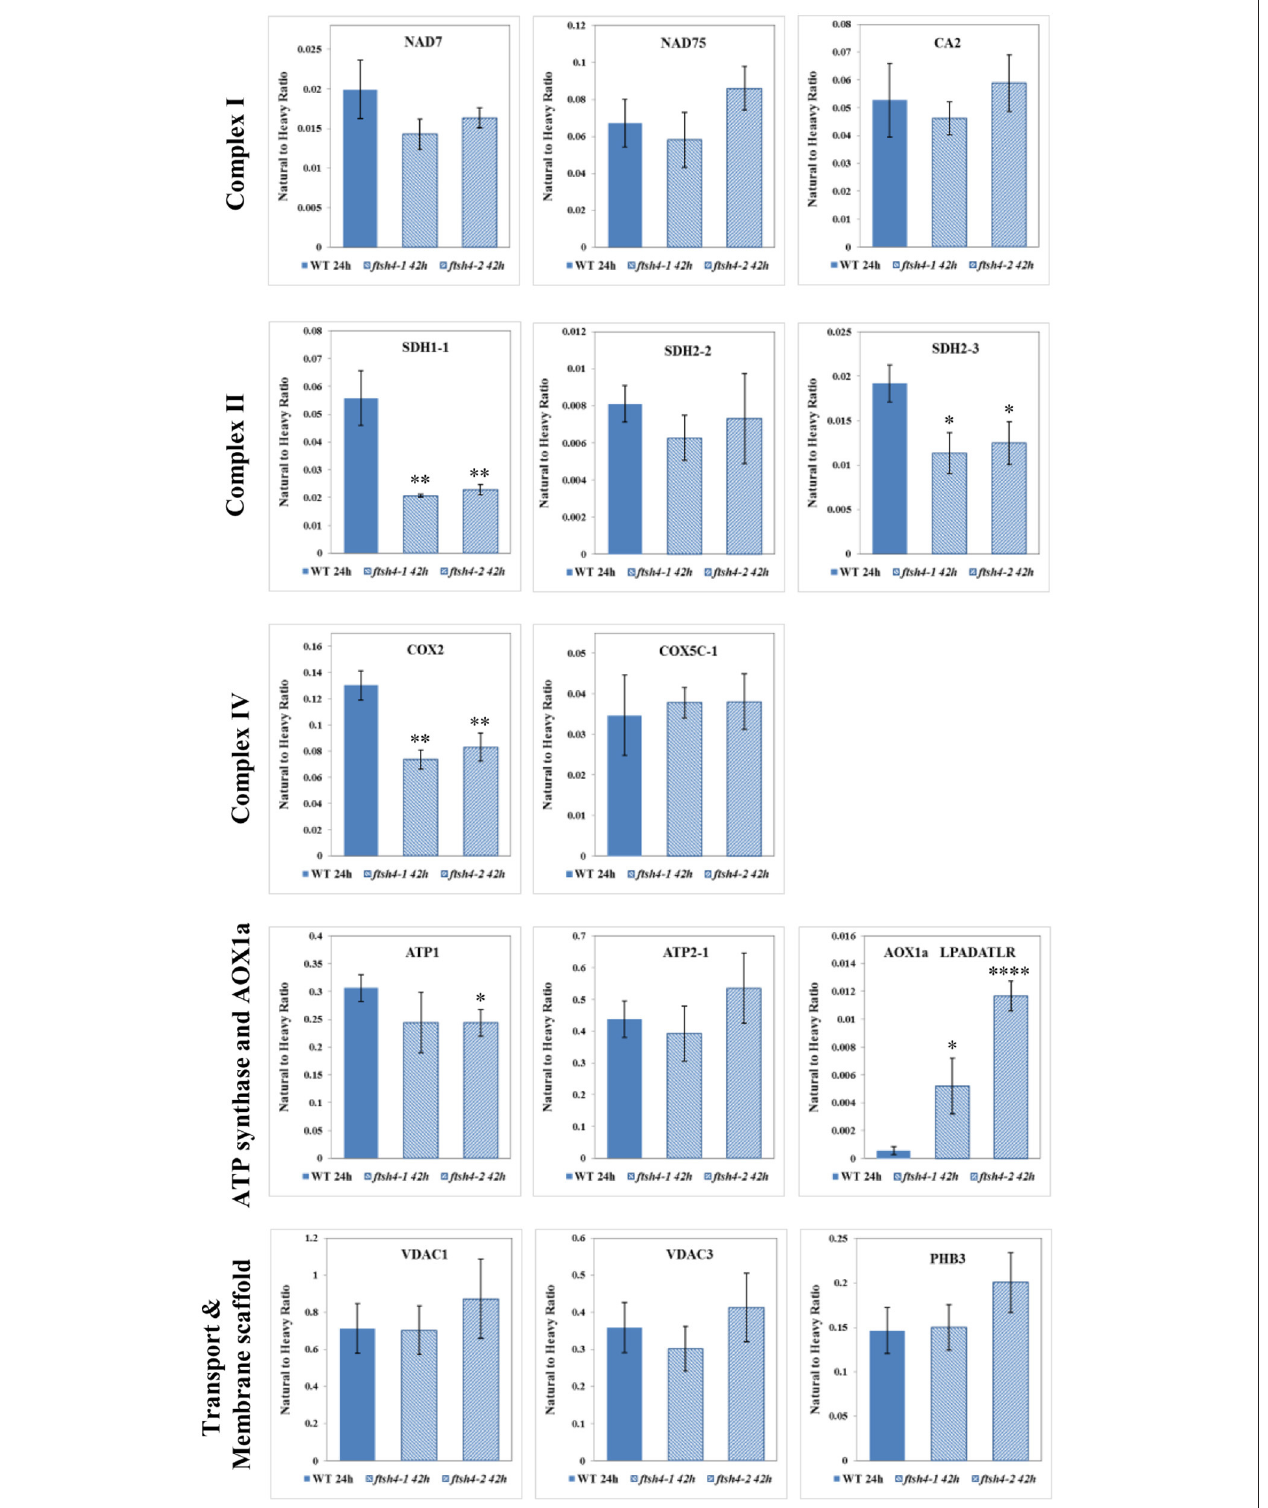
FIGURE 8 | Comparison of the protein abundances between ftsh4 seeds from the 42-h time point and wild-type seeds from the 24-h time point of germination. Protein abundance has been estimated by MRM. Details regarding the studied proteins and the selected peptides are given in Figures 4 – 7 . Data are mean ± SD of three independent biological replicates. * p ≤ 0.05; ** p ≤ 0.01; **** p ≤ 0.0001.